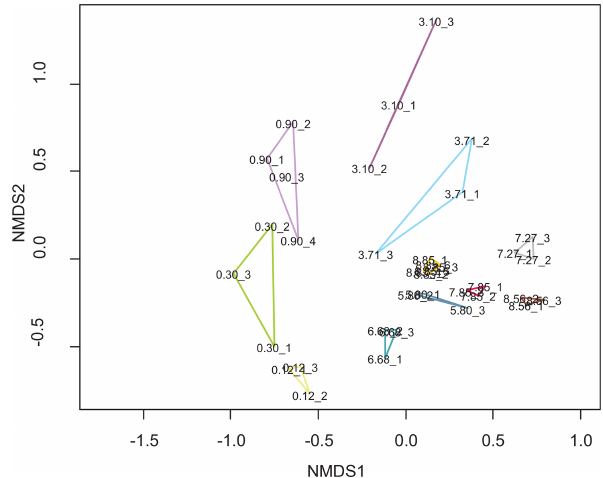
Figure 3. Non-metric multidimensional scaling plot based on the filtered and resampled diatom dataset with the PCR replicates (in- dicated by an underscore with a number) of a sample (depth in m) linked in a polygon of sample-specific colour: light green: 0.12m; green: 0.3m; light violet: 0.9m; violet: 3.1m; light blue: 3.71m; dark blue: 5.8m; turquoise: 6.68m; grey: 7.27m; red: 7.85m; brown: 8.56m; orange: 8.85m (two sample replicates with three PCR replicates